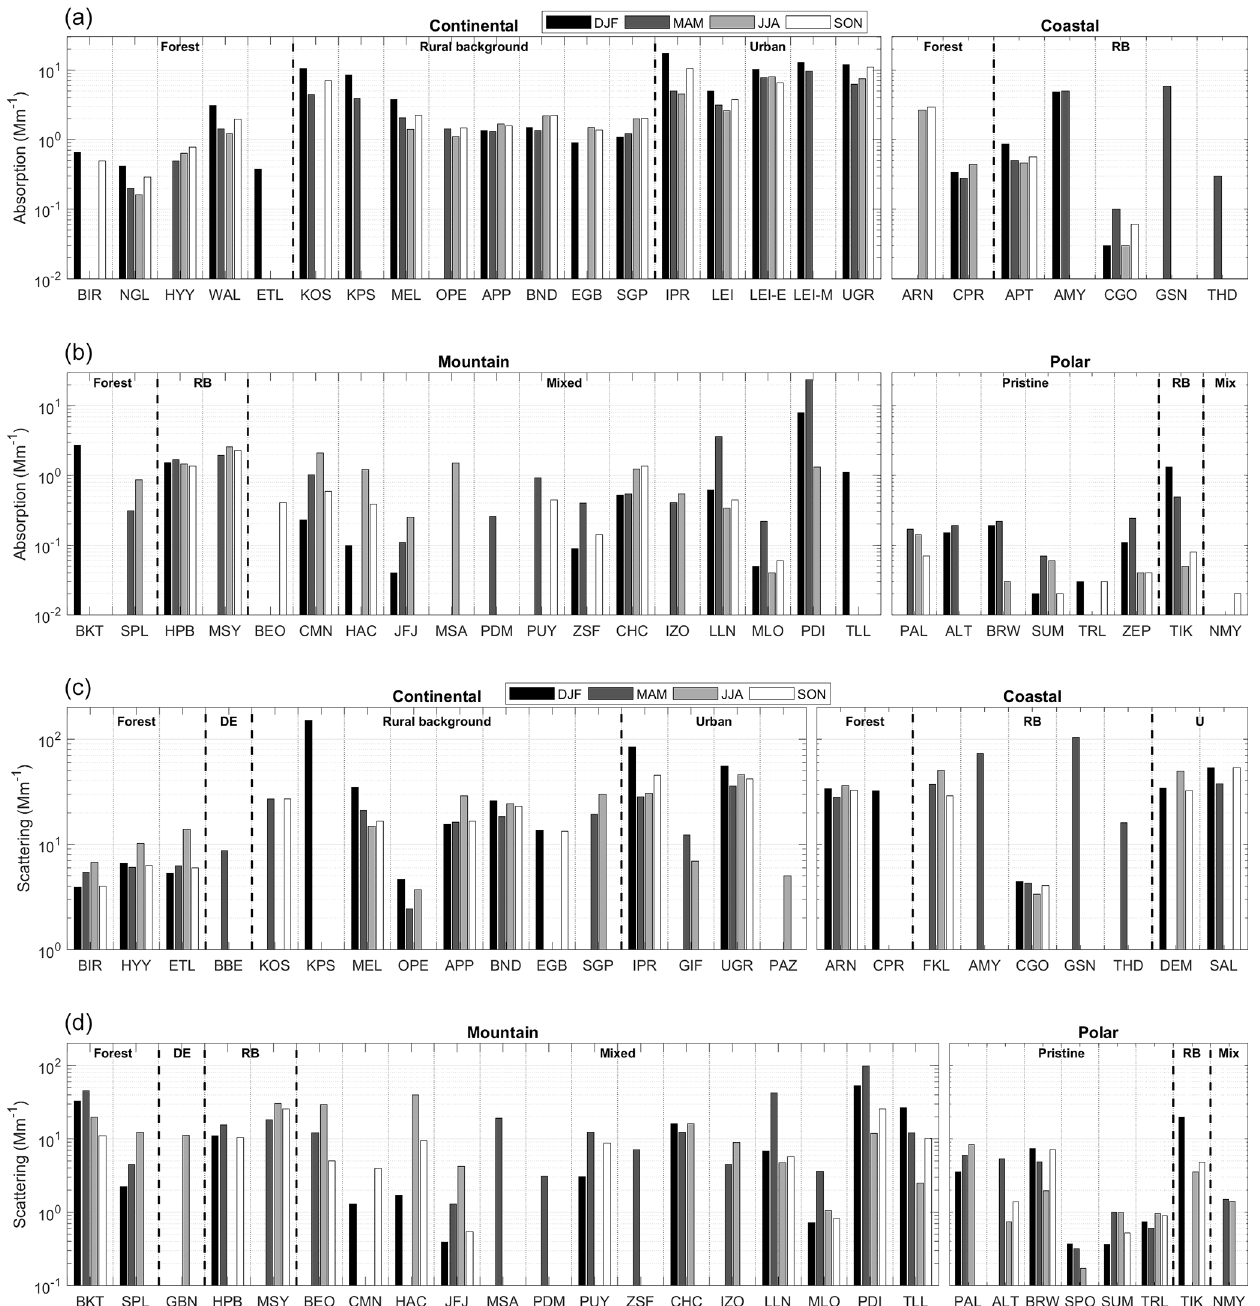
Figure 6. Variation of the seasonal median of absorption coefficient (a, b) and scattering coefficient (c, d) for the different sites, grouped according to site classification of Table 3 with DE (Desert), U (Urban), and RB (Rural